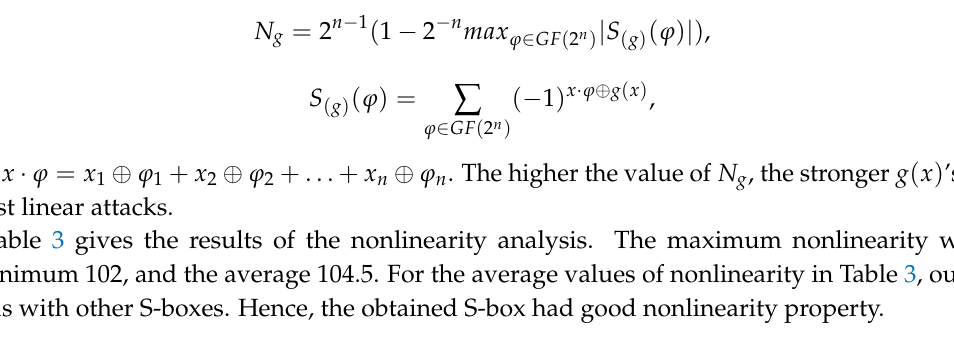
Table 3. The results of the comparison of